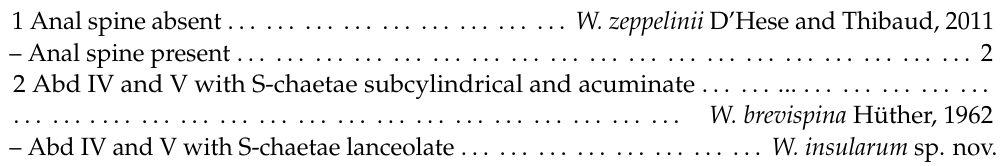
2 Abd IV and V with S-chaetae subcylindrical and acuminate . . . . . . ... . . . . . . . . . . . . . . .